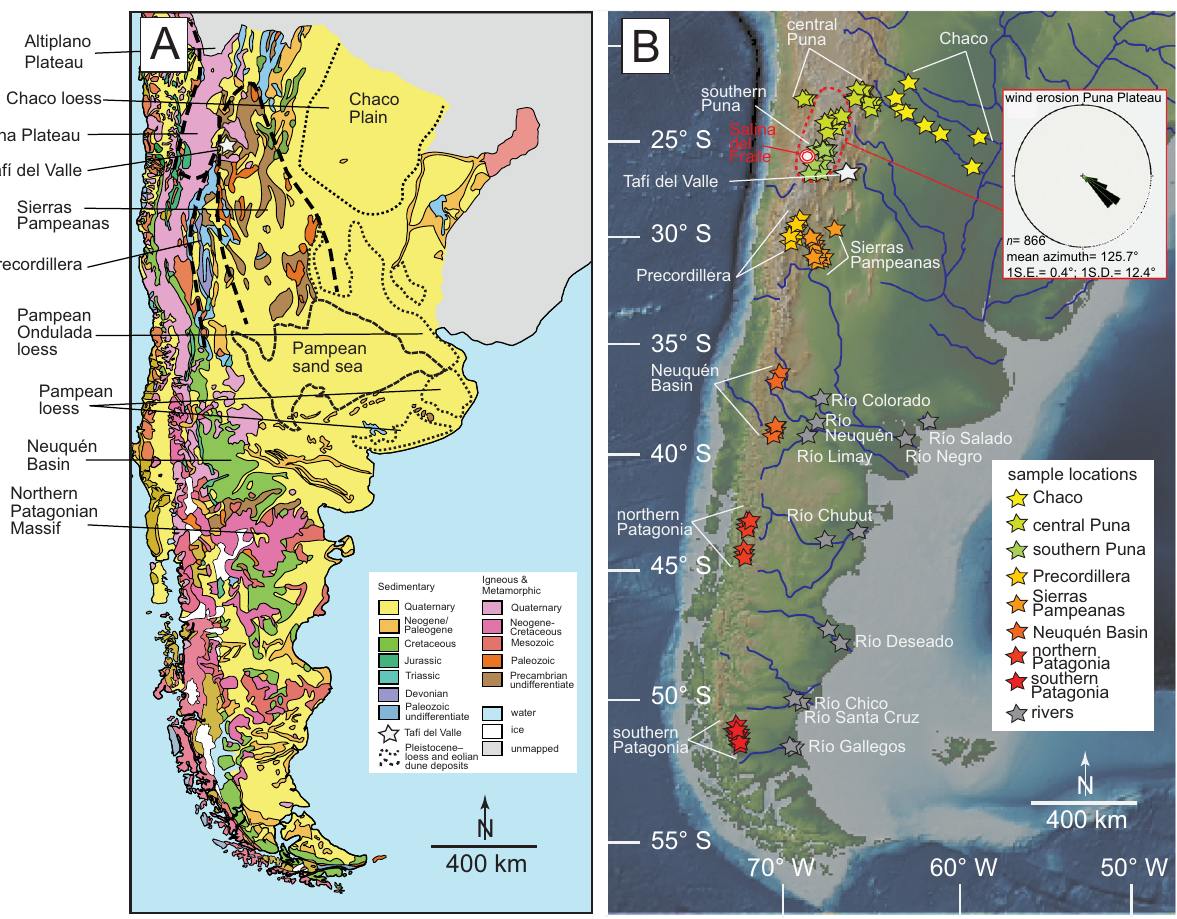
Fig. 1 Maps of southern South America. A Simpli fi ed geologic map of Argentina and central and southern Chile based on compilation maps 54,55 . Distribution of La Pampa loess and Pampean Sand Sea after Iriondo ( 11,46 ) and Zárate ( 7 ). B Digital elevation model for southern portion of South America. Color fi lled stars denote locations of U-Pb zircon samples for comparison with Tafí del Valle samples: southern Puna Plateau 37,38 ; central Puna Plateau 56 – 60 ; Chaco 36,61 ; Sierras Pampeanas 62 – 67 ; Precordillera 67 – 69 ; Neuquén basin 70 ; northern Patagonia 71 ; southern Patagonia 72 ; Ríos Neuquén, Salado, Limay, Colorado, Negro Chubut, Gallegos, Santa Cruz, Chico, and Deseado 36 . Area of wind erosion study of Puna Plateau reported here highlighted by dashed red line; linear wind erosion data shown in inset rose